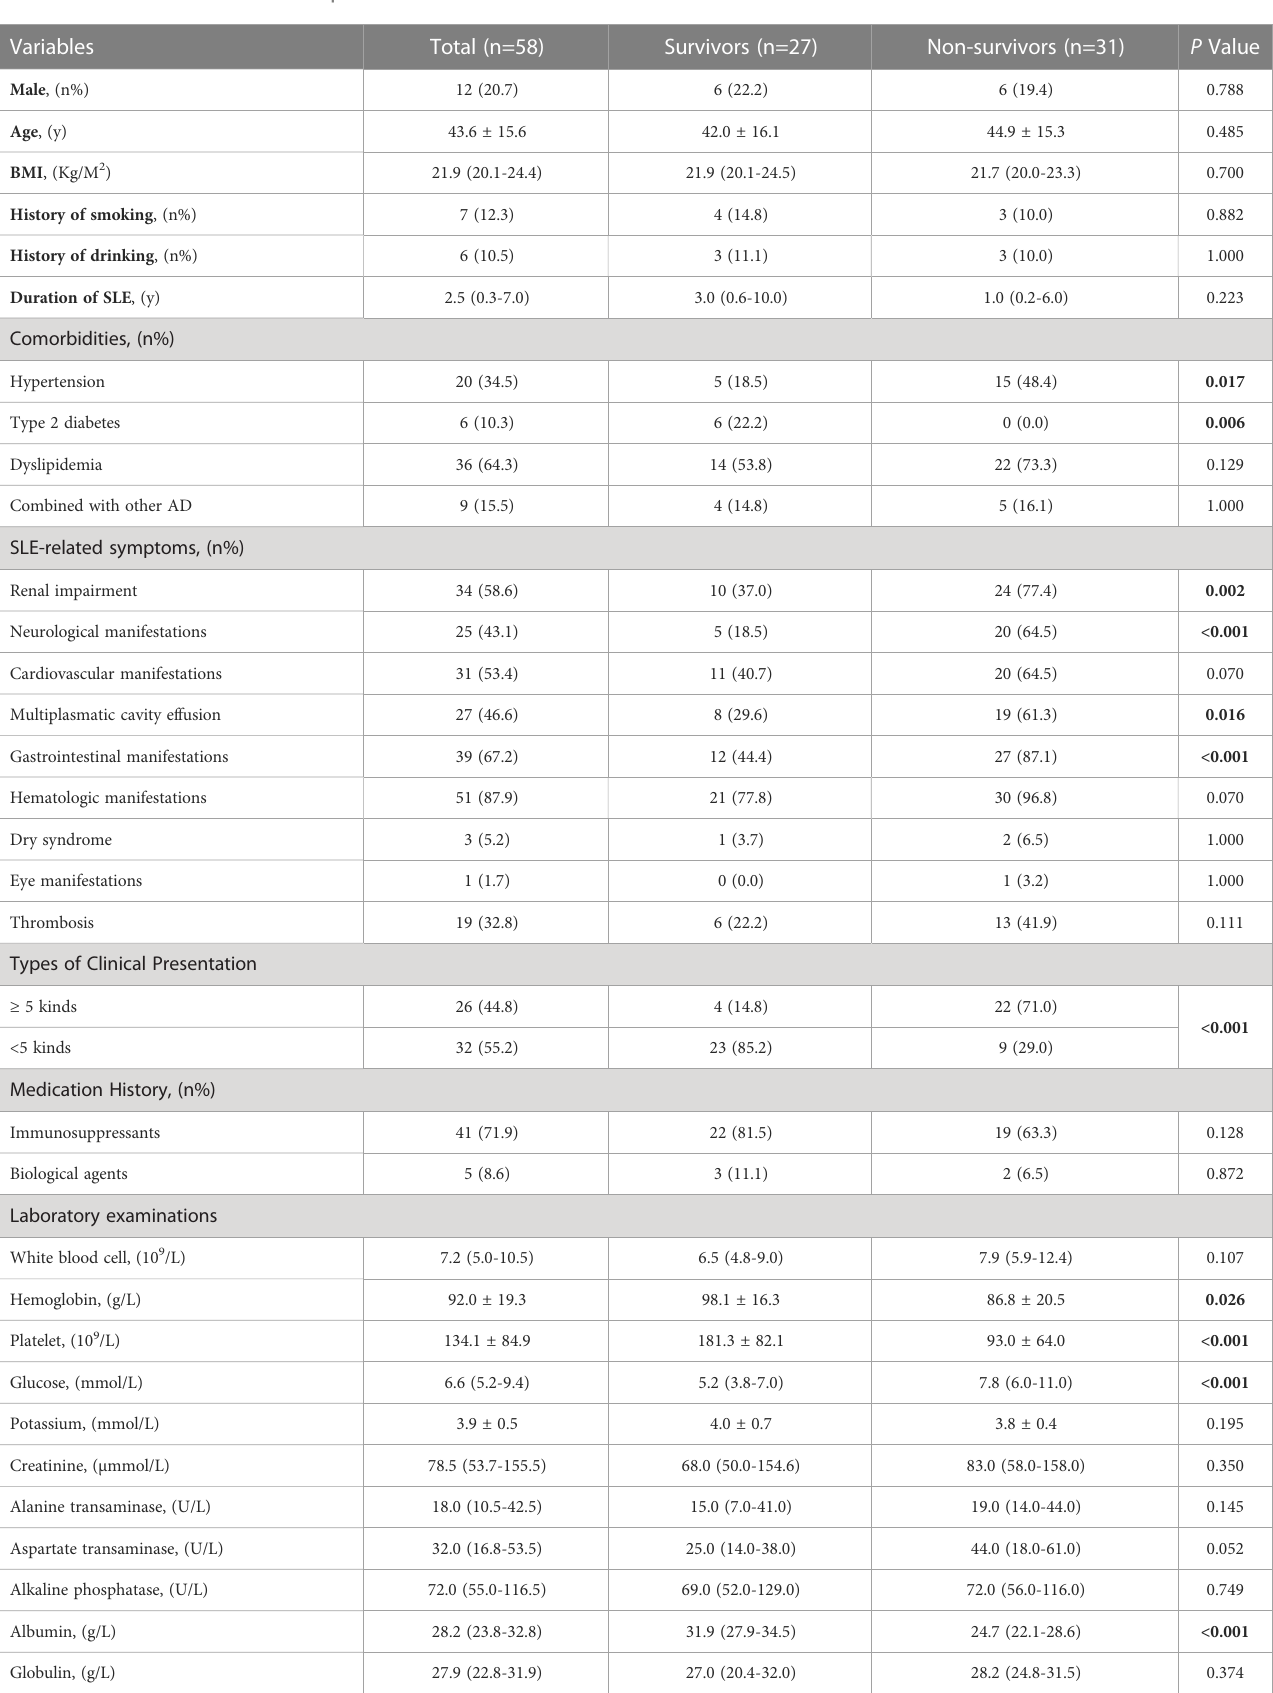
TABLE 1 Baseline characteristics of SLE patients with